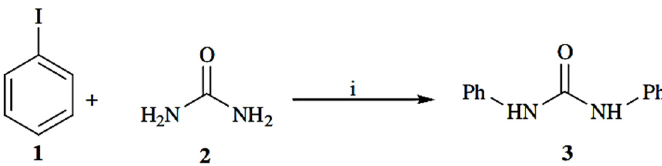
Figure 38. CuI, 1,2-diaminocyclohexane, K 3 PO 4 , DMF, 80 °C, 24 h. From reference [61].